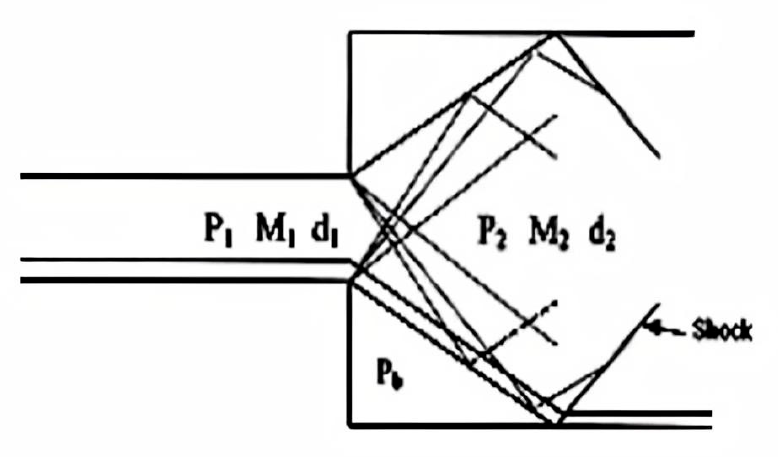
Figure 3. Schematic diagram of the under-expanded flow field.